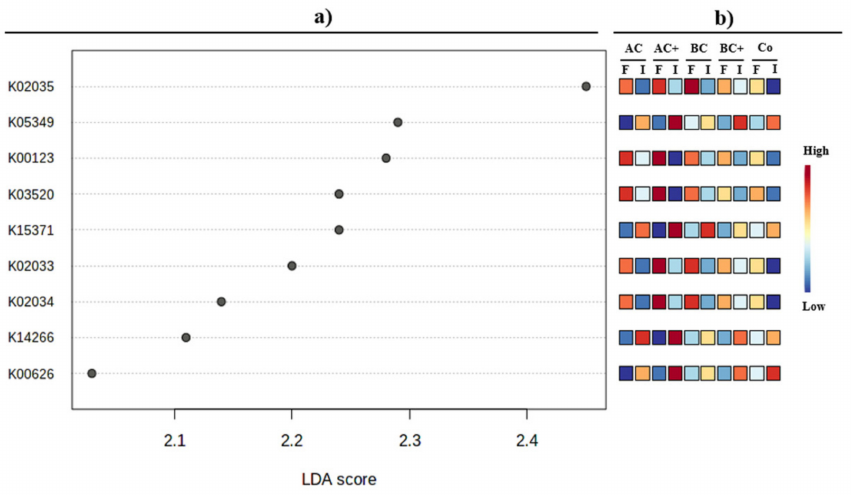
Figure 5. ( a ) Linear discriminant analysis (LDA) scores and, ( b ) heatmap from blue (low) via white to red (high) of KO relative abundances in control soil (Co) and amended soils at low (AC and BC soils) and high doses (AC+ and BC+ soils) at ini-tial (I) and final (F) sampling.